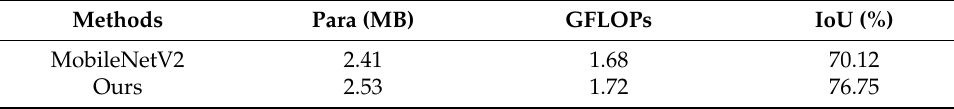
Table 3. Performance of two backbone networks.